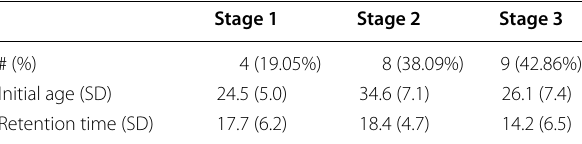
Table 3 Distribution of the regeneration stages, initial age